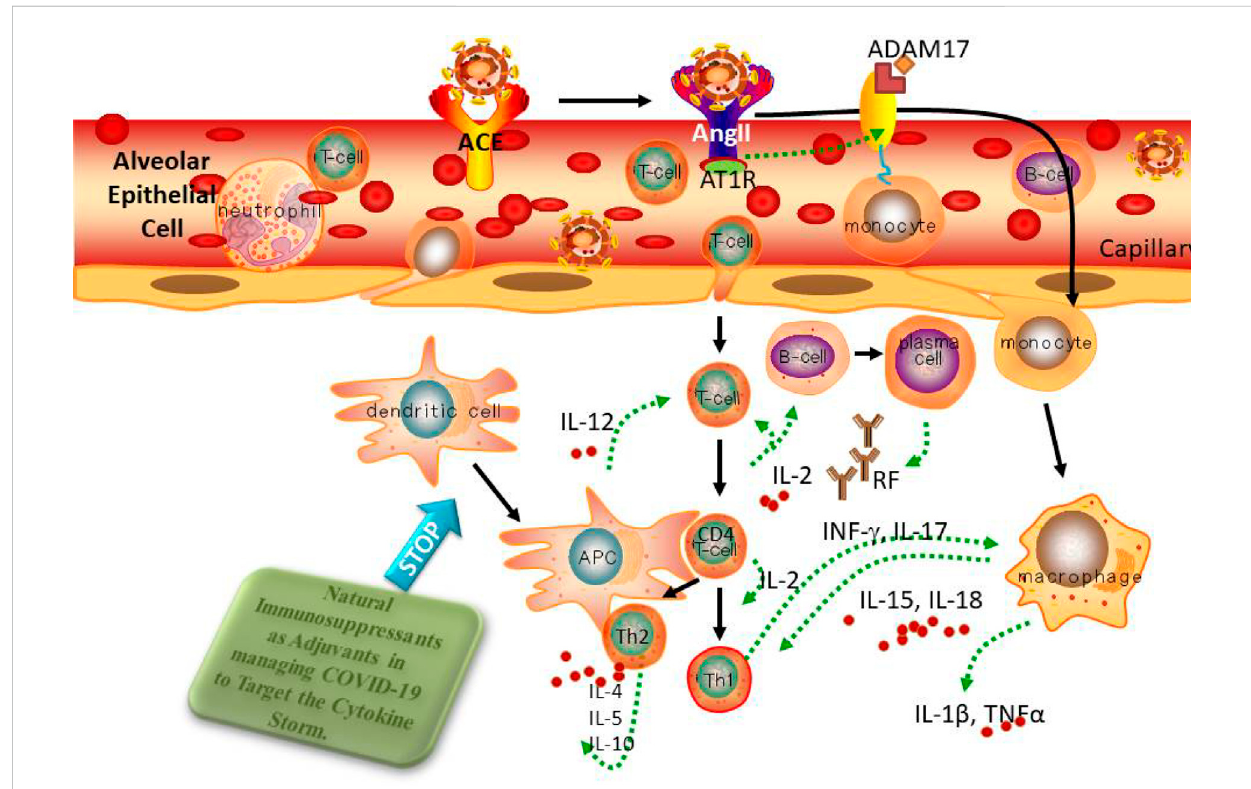
FIGURE 9 Blockingthecytokinestormisaunique,potentialnaturaltreatmenttechniqueforreducingtheexcessivein fl